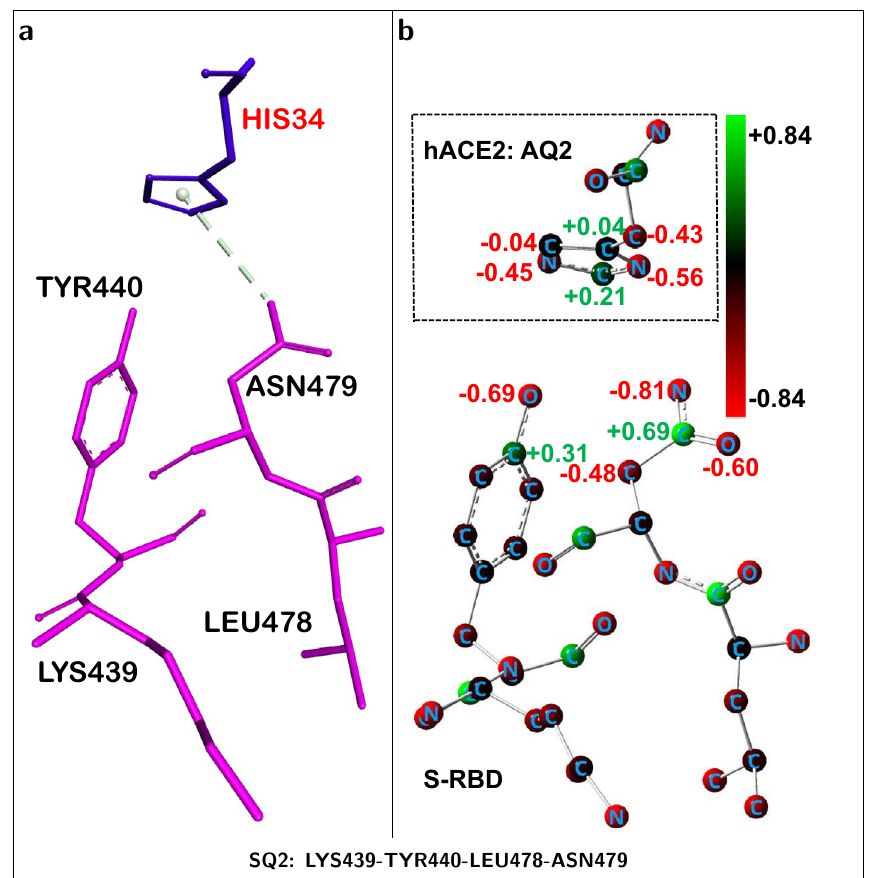
Figure 6. S-RBD-centered fragment producing a net repulsive interaction towards hACE2. ( a ) S-RBD quartet residues (shown in pink) and neighboring ACE2 residues (shown in blue) corresponding to a dominant repulsive ACE2...S-RBD interaction. S-RBD is used as the structural reference. ( b ) Corresponding residue atoms displaying positive partial charge (green spheres) or negative partial charge (red spheres). Atomic partial charges, evaluated with NBO 33 method, for selected atoms are shown. The electrostatic hACE2...S-RBD interface, for this fragment, is dominated by negatively charged (red) atoms leading to a net intermolecular repulsion. Positively charged hydrogen atoms not